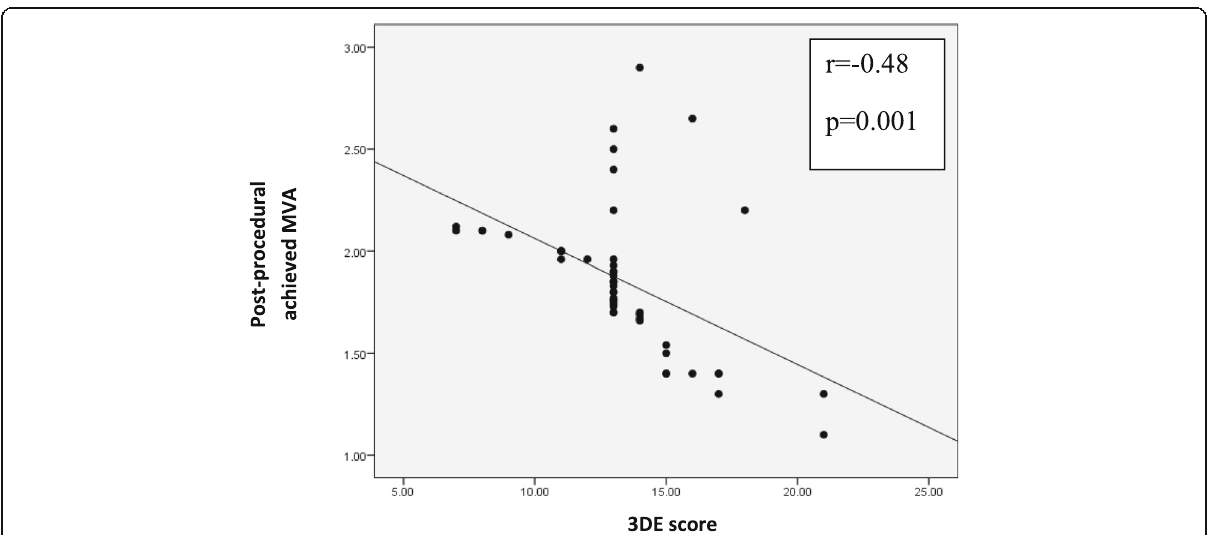
Fig. 3 Correlation between 3D-Anwar score and achieved post-procedural mitral valve area